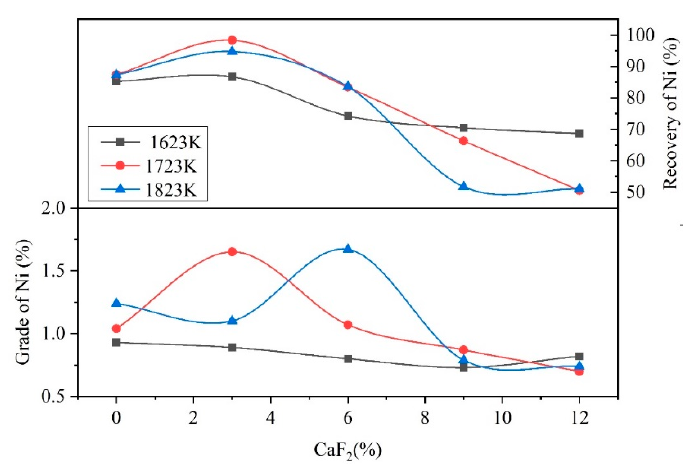
Figure 14. The effect of additives and temperature on Ni enrichment (%), the upper three lines in the figure represents the recovery of Ni, and the lower three lines in the figure represents the grade of Ni.